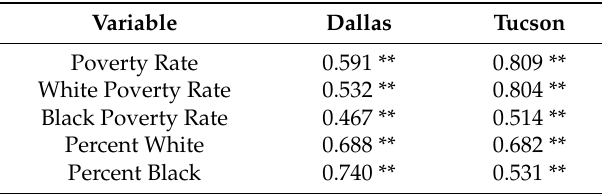
Table 5. Moran’s I for Growing Cities in